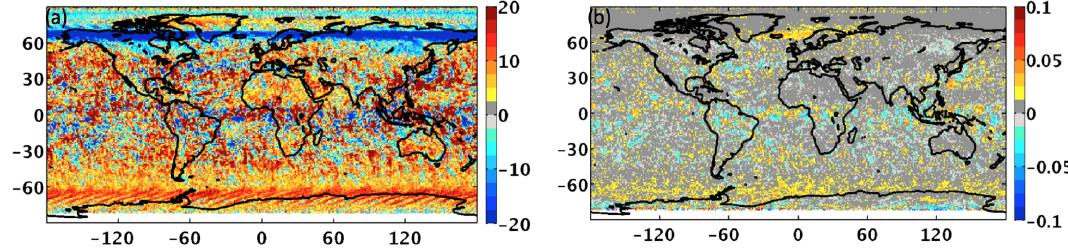
Figure 4. Monthly mean (a) TOA-reflected SW flux difference between NPP CERES and Aqua CERES (NPP–Aqua), and (b) albedo difference between NPP CERES and Aqua CERES (NPP–Aqua) for April 2013.